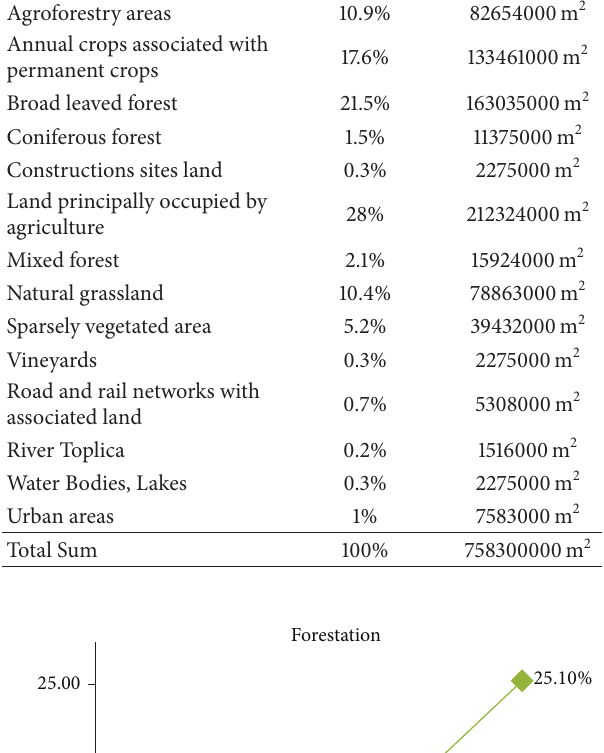
Table 3: The percentage and area of types of land on the territory of Prokuplje Municipality in m 2 in 1974.